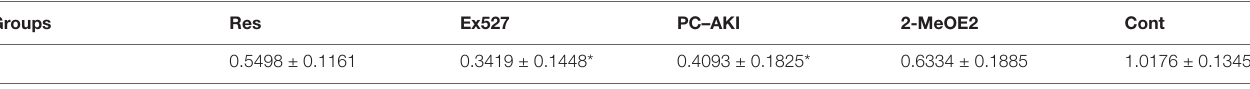
TABLE 3 | Quantitative analysis of the percentage of viable cells in different